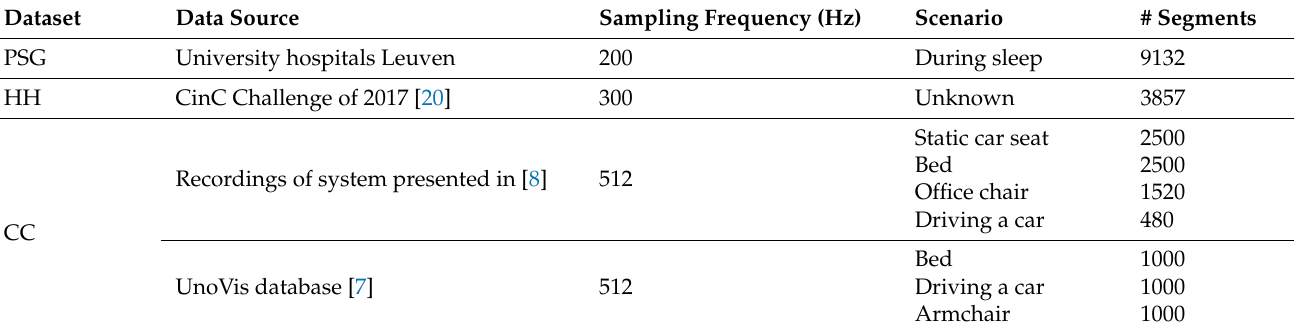
Table 1. Overview of all